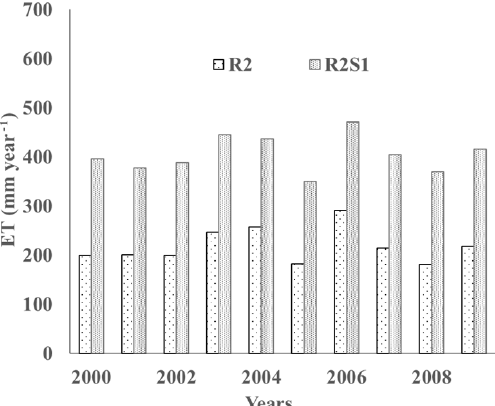
Figure 8. Monthly ET simulated under the irrigation operation sce- narios (R2S1 and R2S2) relative to the reservoir operation-only sce- nario (R2).